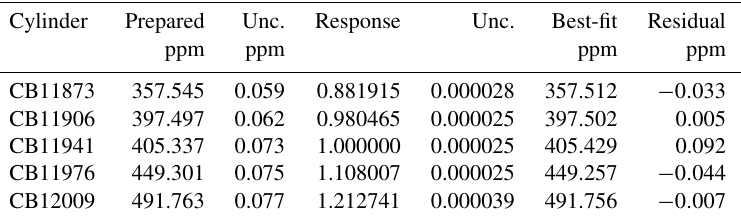
Table 4. Analysis of CO 2 -in-air standards. Best-fit values were determined from a linear fit (response vs. prepared CO 2 ) using orthogonal distance regression, with fit coefficients equal to 2 . 4644 × 10 − 3 and 8 . 7851 × 10 − 4 . Uncertainties (unc.) are shown as a ∼ 68% confidence level. Results are not sensitive to how the response was normalized.